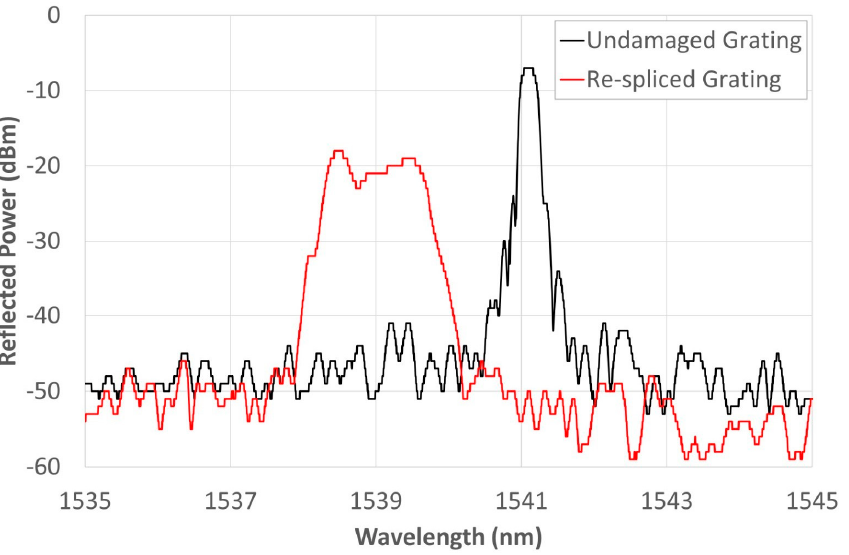
Figure 5. Comparative analysis of FBG sample underwent intentional breaking and subsequent re-splicing. The measurement was performed at RT and the CWL was identified at 1541.01 nm. Figure taken from reference [29].